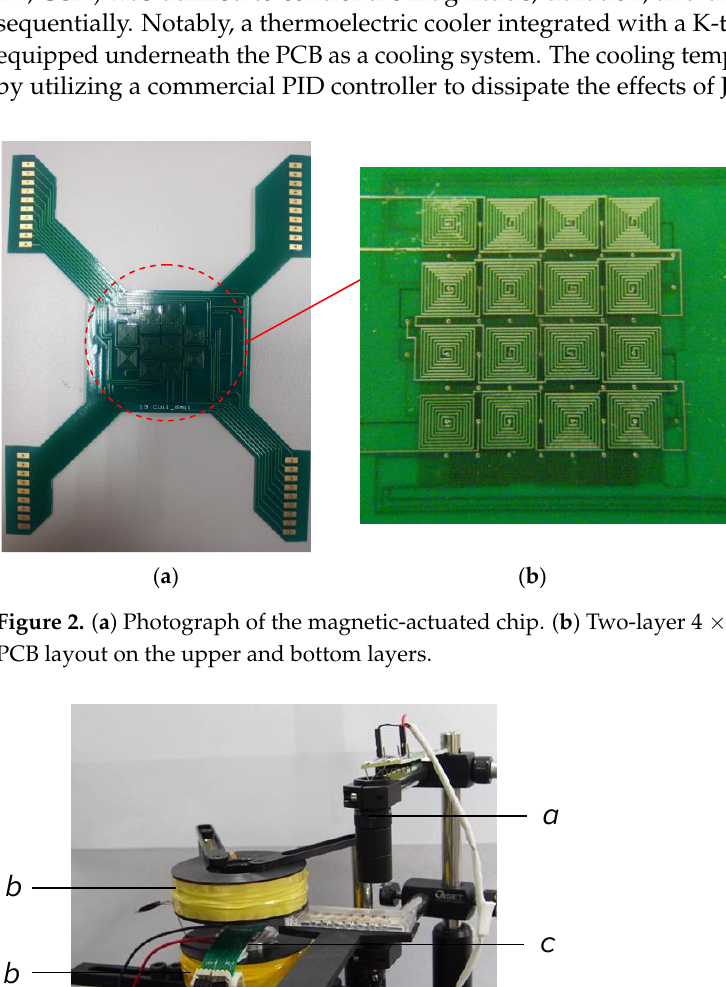
Figure 2. ( a ) Photograph of the magnetic-actuated chip. ( b ) Two-layer 4 × 4 array micro-coils of the PCB layout on the upper and bottom layers.